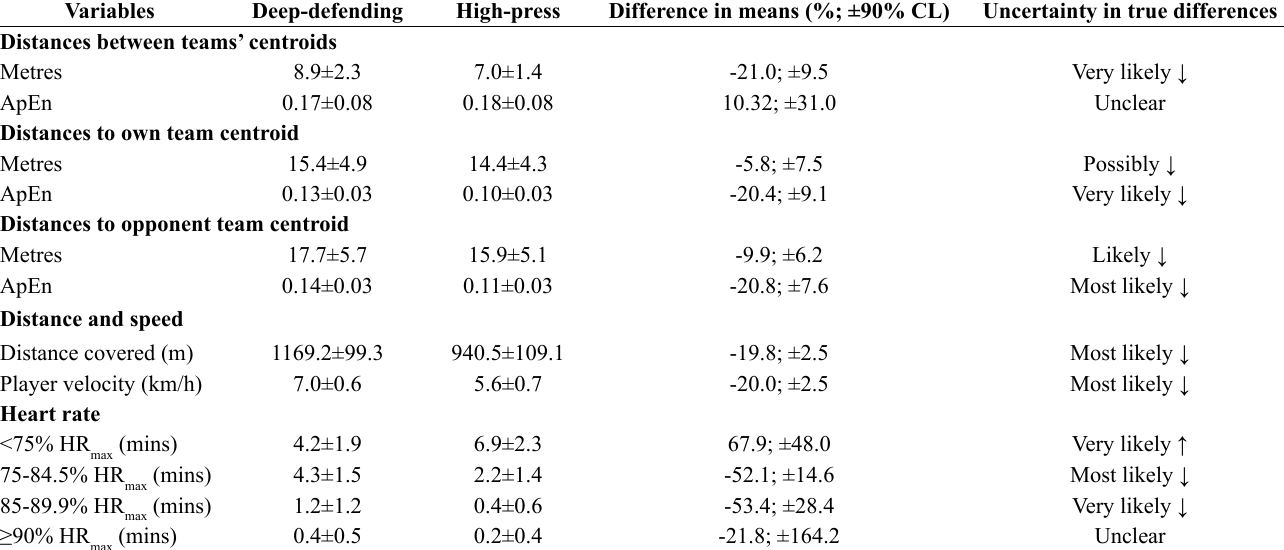
Table 1. Descriptive analysis for both deep-defending and high-press